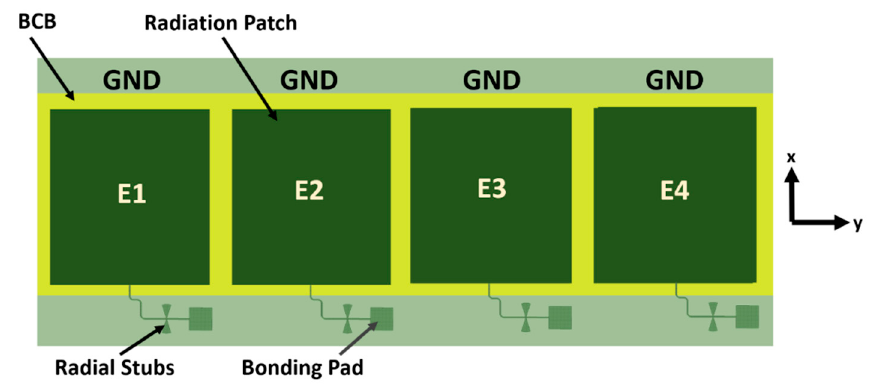
Figure 4. Top view of the designed 1 × 4 antenna array.